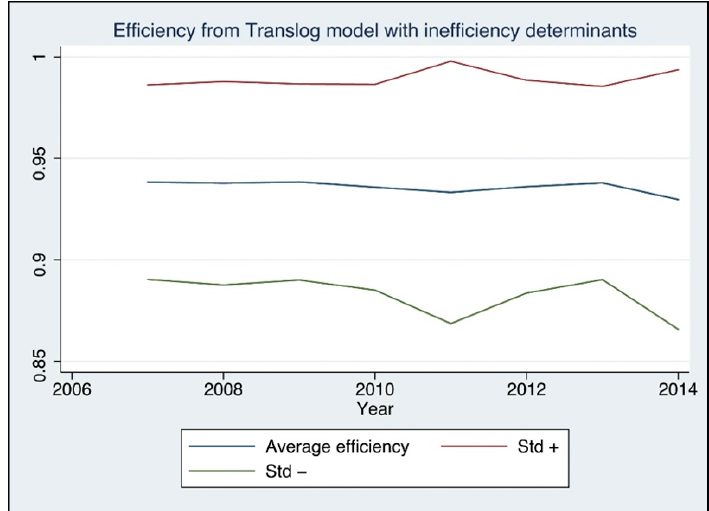
Figure 3. Annual evolution of efficiency.